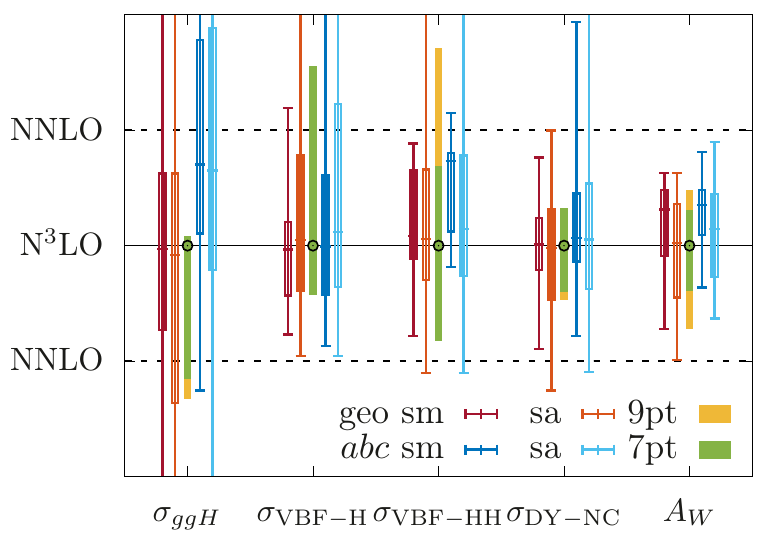
Figure 24 . Comparison of MHO estimates at N 3 LO between different models and scale prescrip- tions for the gluon-fusion Higgs cross-section, single and di-Higgs production in vector boson fusion, neutral current Drell-Yan production and the lepton charge asymmetry. See the corresponding sec- tions for each process for further